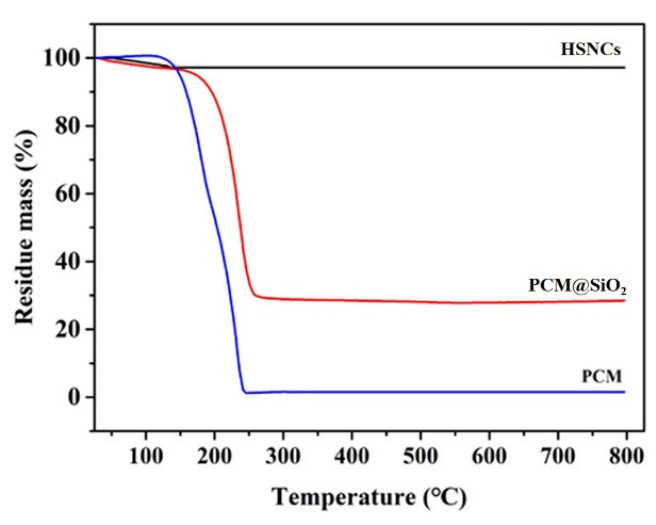
Figure 6. TGA curves of PCM, HSCNs and PCM@SiO 2.